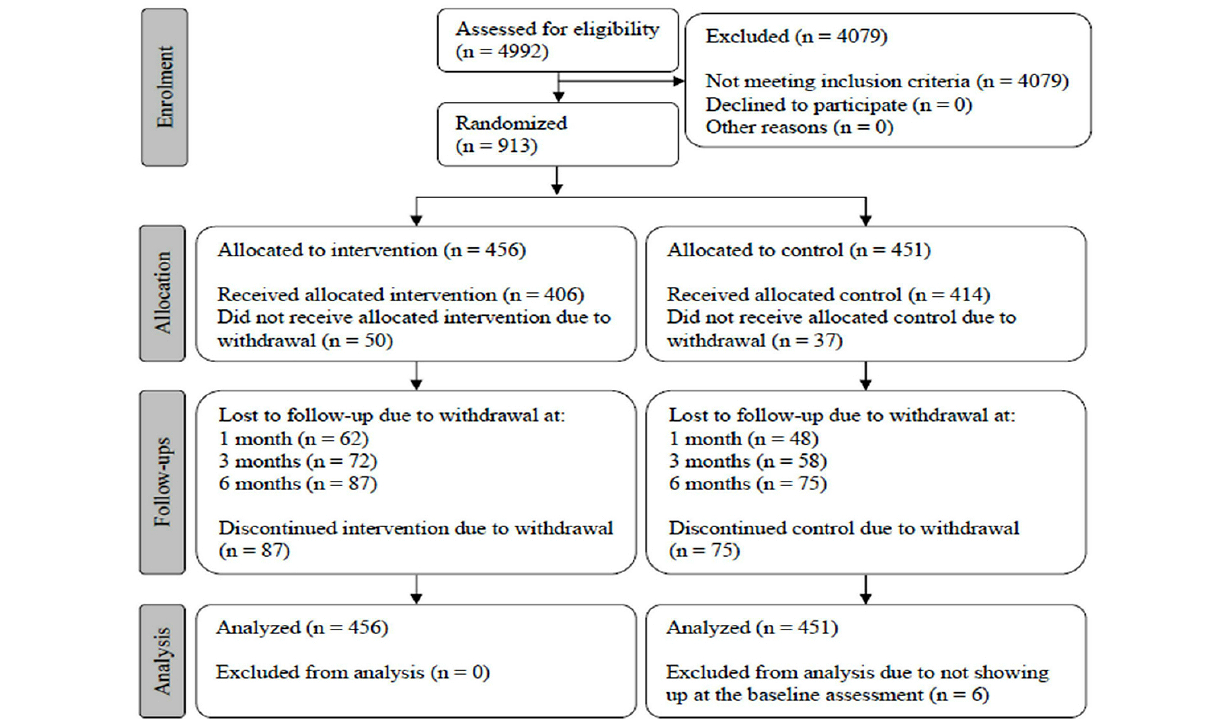
Figure 5. Participant flow